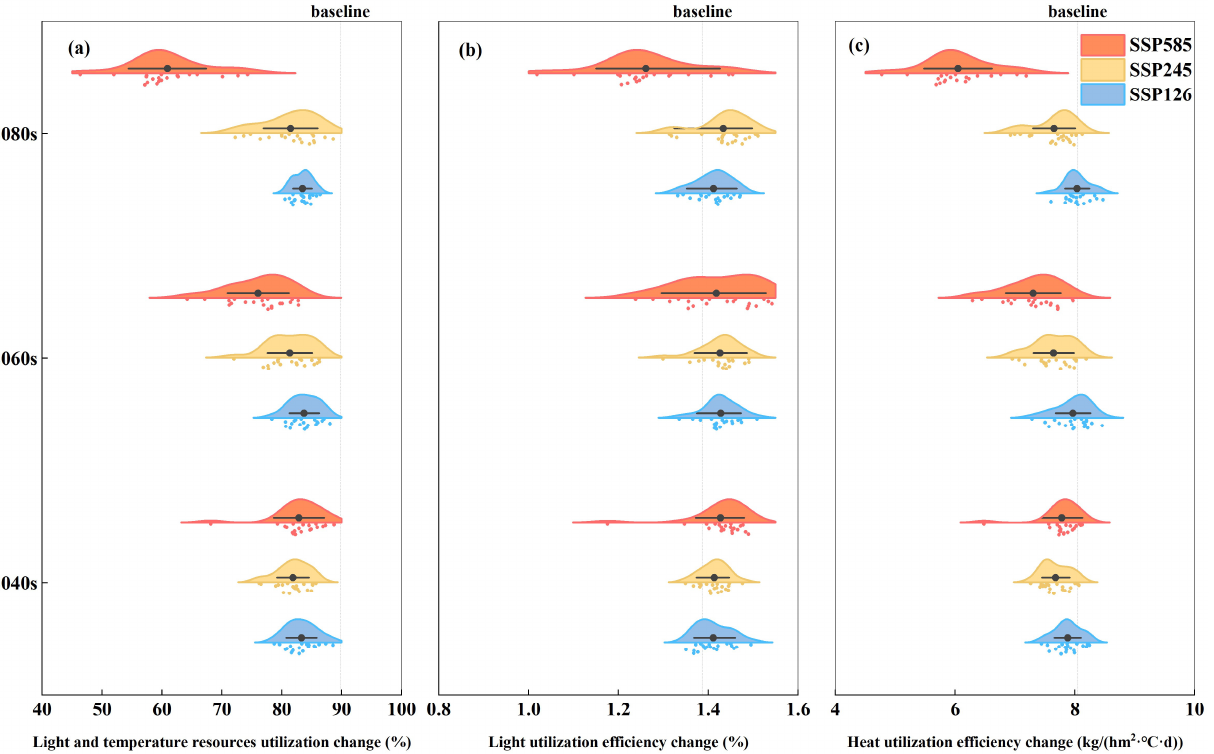
Figure 8. Simulated change in the light and temperature resources utilization, the light utilization efficiency, and heat utilization efficiency in the 2040s, 2060s, and 2080s under SSP126, SSP245, and SSP585 scenarios relative to 2000–2019 (baseline) using six GCMs for Qing’an station in the Songnen Plain.